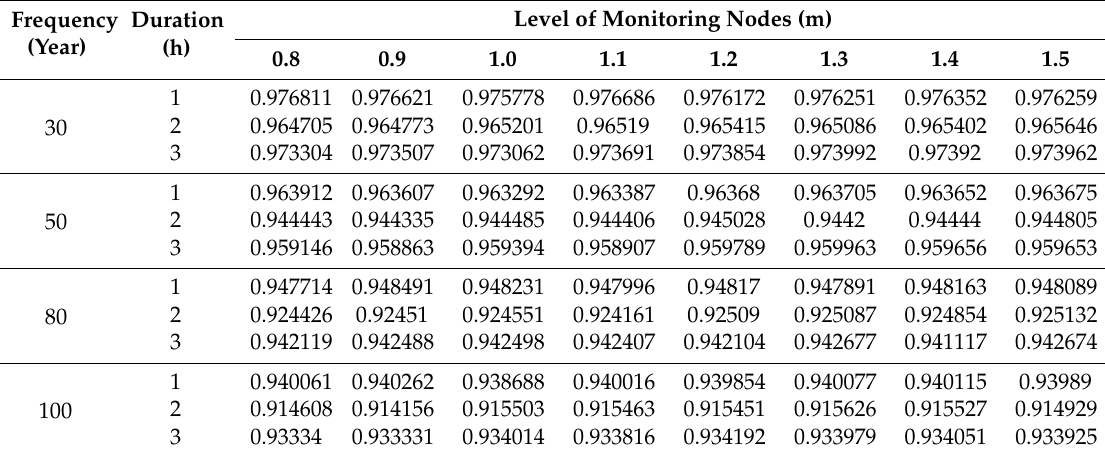
Table 2. System resilience based on Huff distribution synthetic rainfall